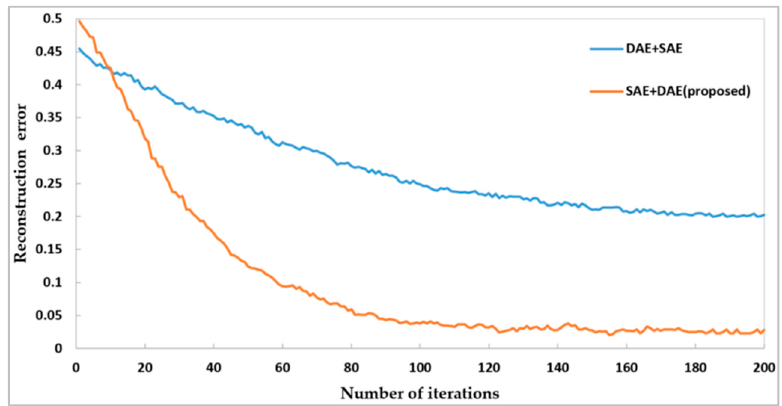
Figure 15. Reconstruction error of the two schemes.